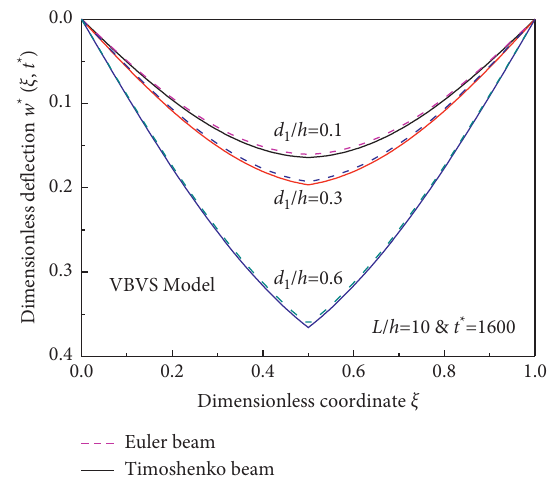
Figure 11: Distribution of dimensionless deflection w ∗ ( ξ , t ∗ ) versus dimensionless coordinate ξ of viscoelastic Timoshenko and Euler cracked beams with different crack depth d 1 / h .